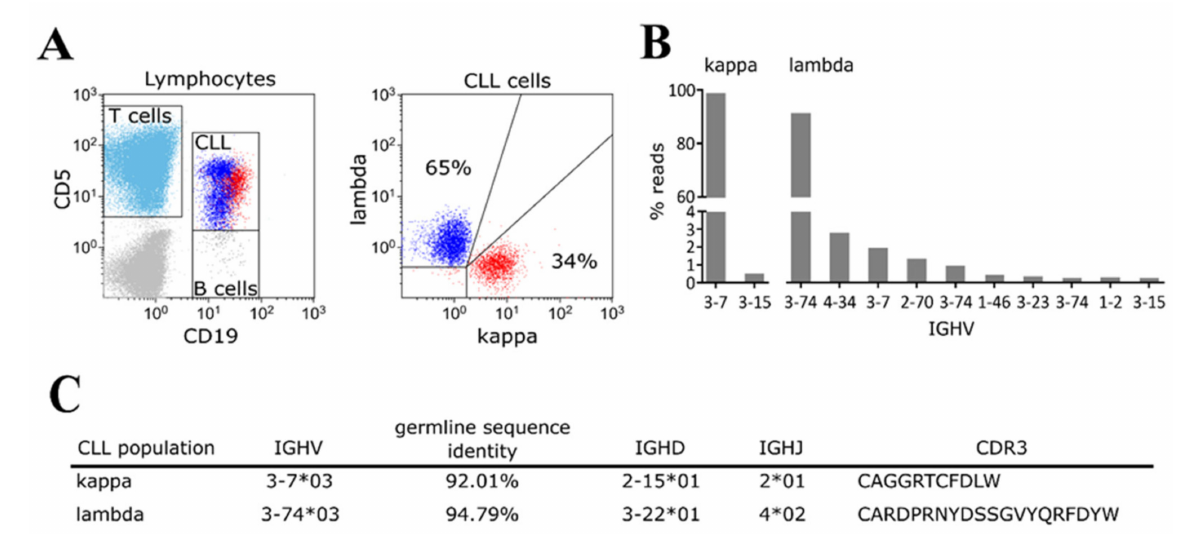
Figure 1. Flow cytometric staining and B cell receptor analysis of a CLL patient with dual clones. ( A ) Refractory CLL with two distinct immunoglobulin light chain clones (kappa/lambda) was measured in flow cytometry 27 months after treatment initiation with ibrutinib. ( B ) Analysis of B cell receptors of sorted kappa and lambda CLL cells taken 18 months prior to ibrutinib therapy revealed two distinct major IGHV clones in kappa and lambda light chains. ( C ) Overview of both major IGH clones found in the sorted kappa and lambda light-chain CLL cells. Both showed mutated (92.01% and 94.79% germline sequence identity) IGHV regions and distinct IGHD, IGHJ, and CD3 regions.